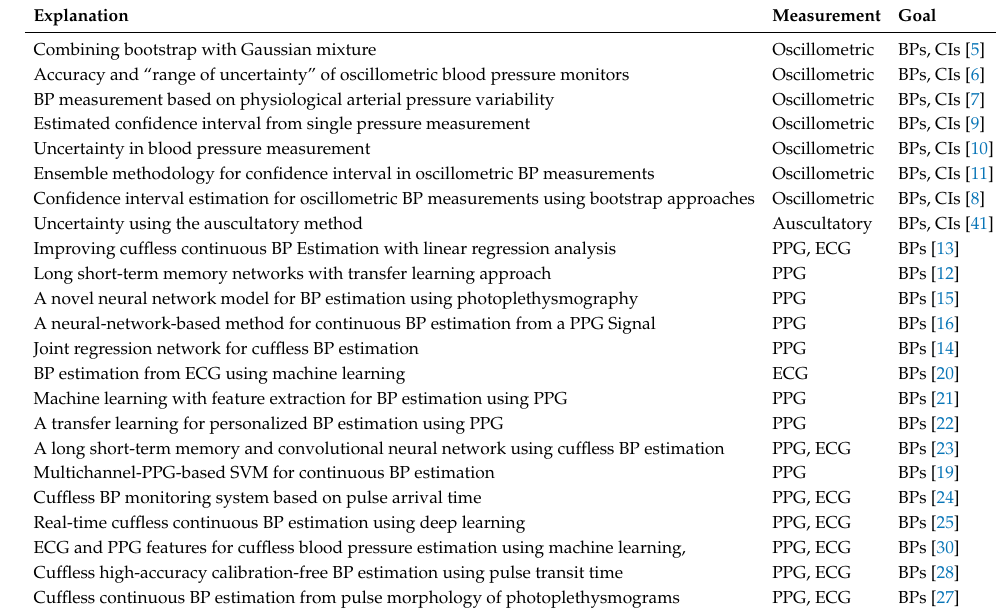
Table 1. Summary of the BP estimation literature where BPs denote systolic and diastolic blood pressures, CIs are confidence intervals to represent an uncertainty